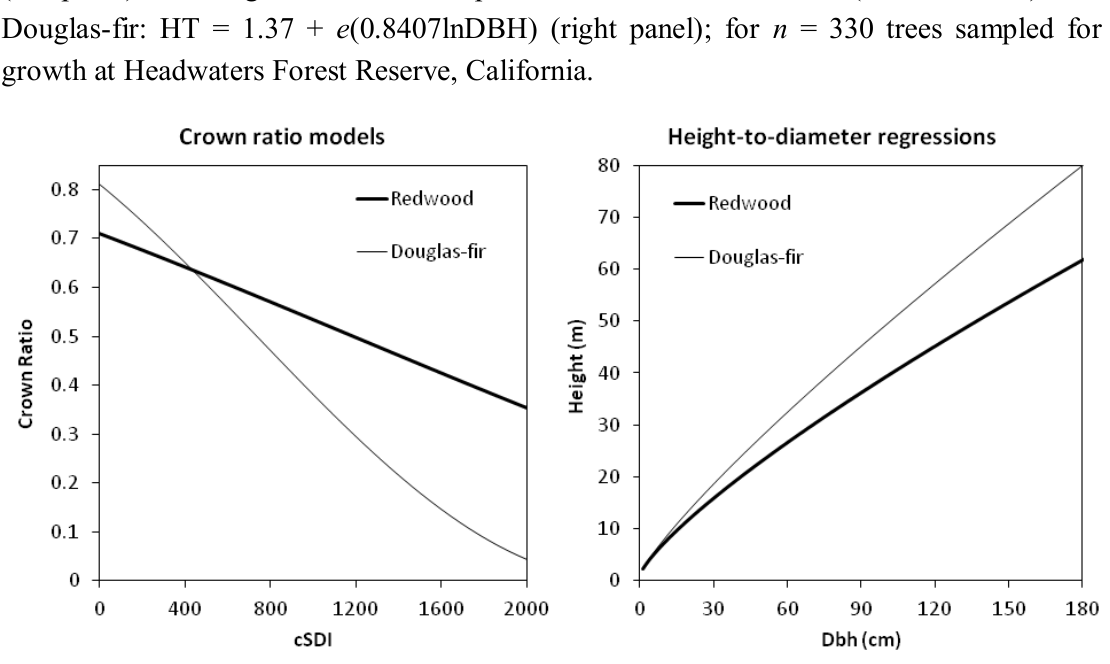
= sin(1.121 − 0.0004553cSDI) 2 df